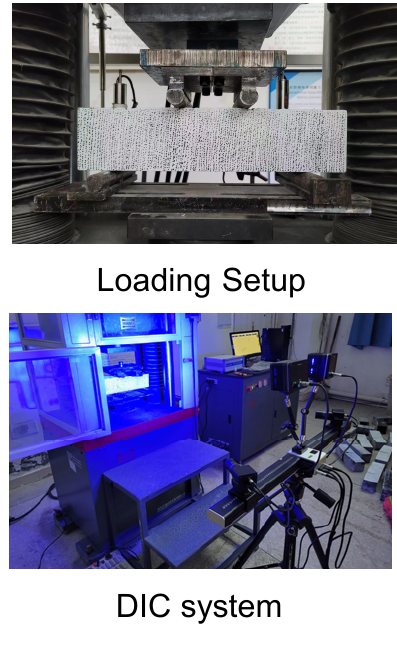
Figure 5. Loading setup and measurement